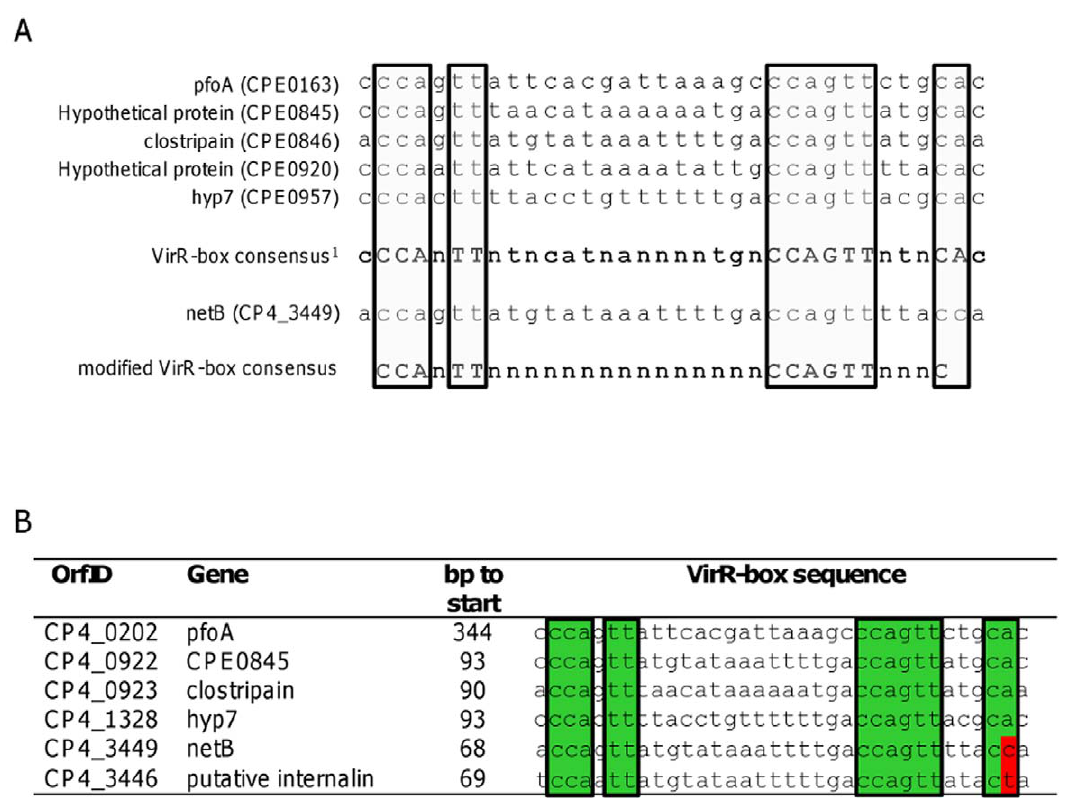
Figure 2. Identificationof VirR boxes in NE strain genomes. (A). A modified VirR-box consensus sequence was produced based on the alignment of known VirR-boxes with the VirR-box upstream from netB . The VirR-box consensus previously reported by Cheung et al. (2004) [79] is shown in bold, and absolutely conserved nucleotides are in boxes. (B) VirR-boxes identified in CP4, including one novel element upstream of the internalin-like protein gene. Nucleotides that conform with the previously reported VirR-box consensus are in green, and those that do not conform in